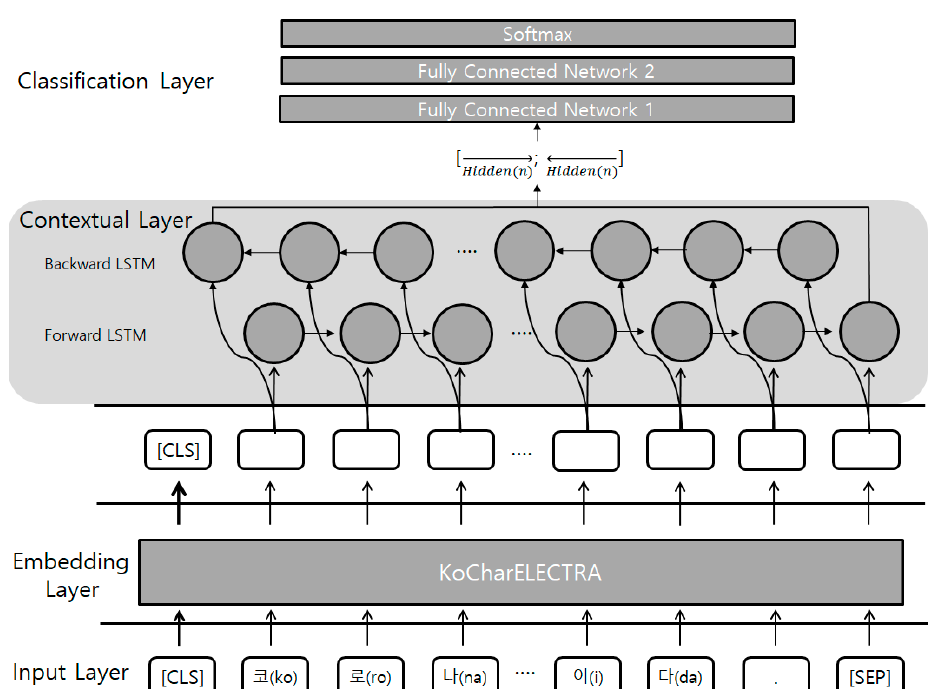
Figure 3. The proposed model in detail.